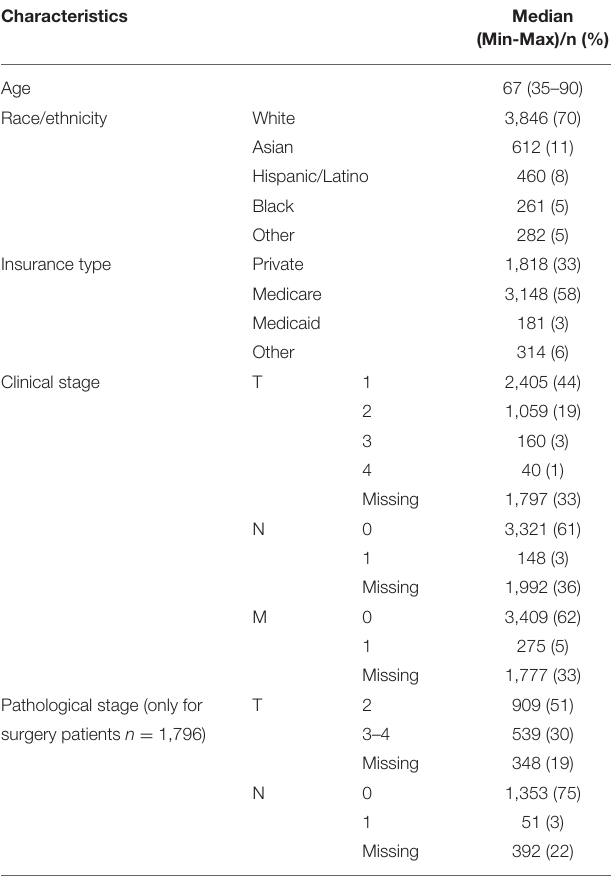
TABLE 1 | Cohort characteristics ( n = 5,461).